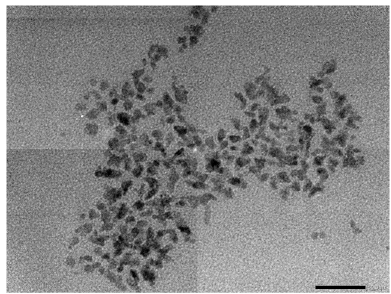
Figure 2. TEM image of CuO nanocrystals synthesized by a hot-soap method. The scale bar is 50